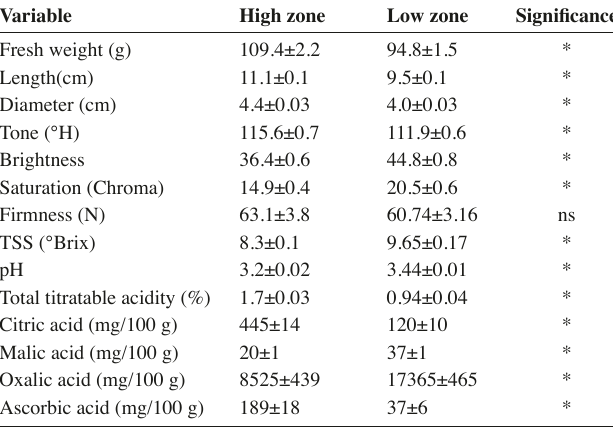
Tab. 3: Physicochemical characteristics of P. tripartita var. mollissima fruits in a high zone (2,498 m.a.s.l.) and a low zone (2,006 m.a.s.l.) in the municipality of Pasca (Cundinamarca, Colombia). The values indicate the means ± the standard error ( n =40). The * indicates significant differences according to the t-student test (p≤0.05), ns: not